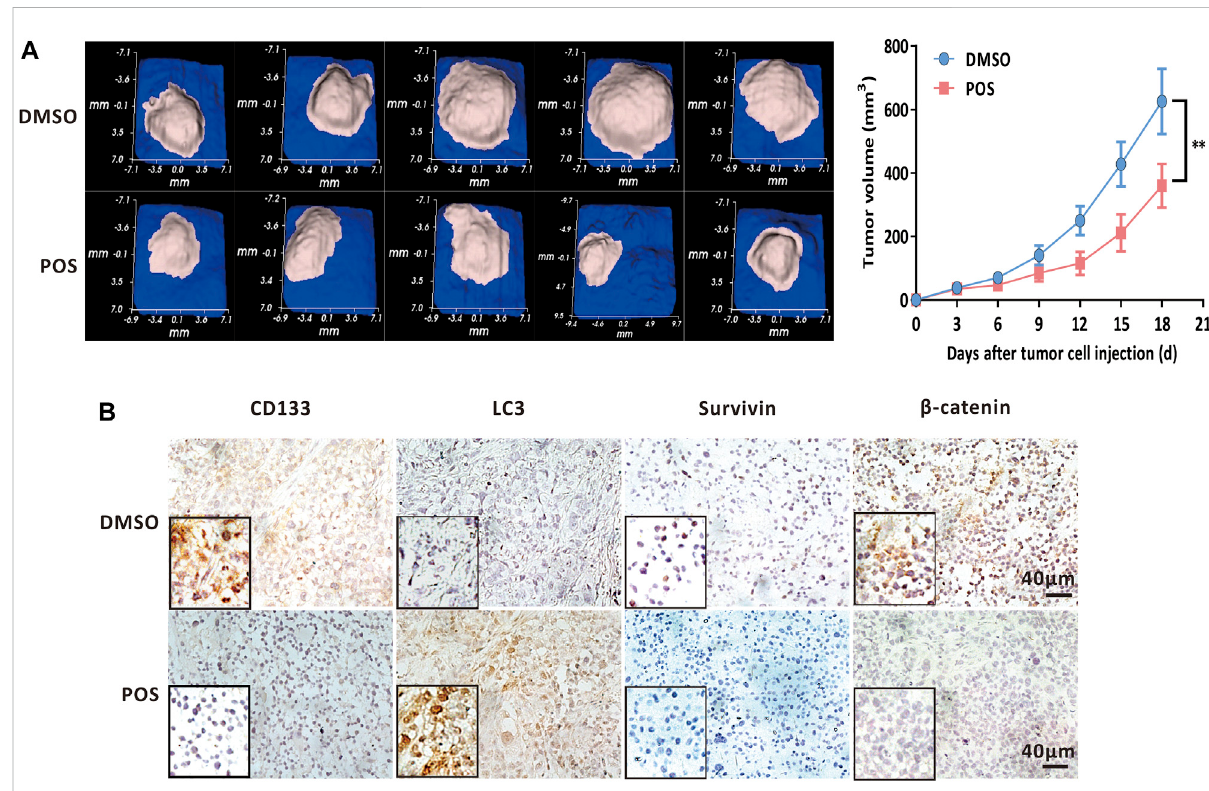
FIGURE 8 POS decreases GBM tumor growth in vivo. (A) U87-MG cells were subcutaneously implanted into immunode fi cient nude mice. The mice were randomly divided into 2 groups and administered DMSO or POS at intervals of 3 days for a total of 6 administrations. The tumor volumes were detected every 3 days. Left, tumor images were photographed on the 18th day. Right, tumor volumes was measured at different time points ( n = 5). (B) ExpressionofLC3,CD133,survivinand β -catenininU87-MGxenograftsthatwerecollectedfromDMSOorPOS-treatedmicewasmeasured by immunohistochemical analysis. Scale bar: 40 μ